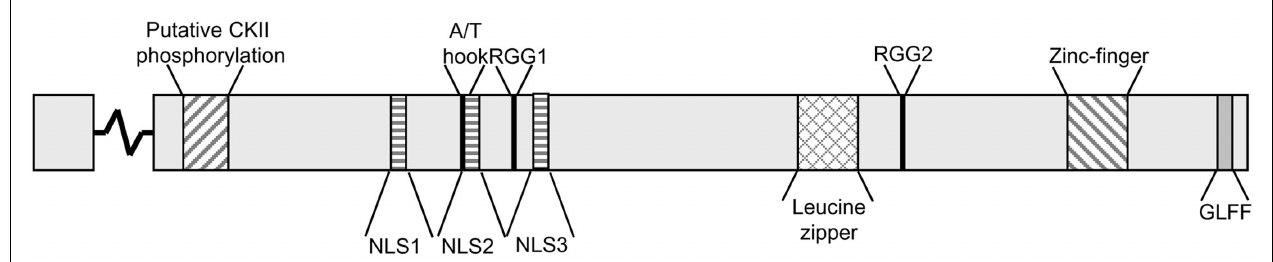
(RGG1,2; regions 138–140, 372–374); a leucine zipper (region 343–364); a zinc finger domain (region 423–432); and a hydrophobic glycine–leucine–phenylalanine–phenylalanine motif (GLFF; region 448–451). The putative phosphorylation sites were predicted using GPSV2.1 (Xue et al., 2008).